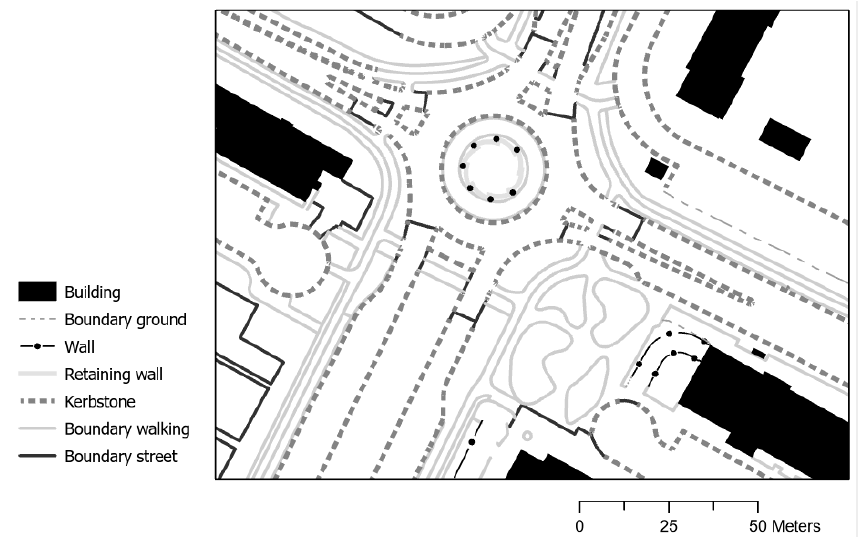
Figure 10. Part of the base map from Malmö city with line features that were used to digitise the transportation polygons in the area shown. Buildings are included for illustration, as some line features are connected to the buildings.